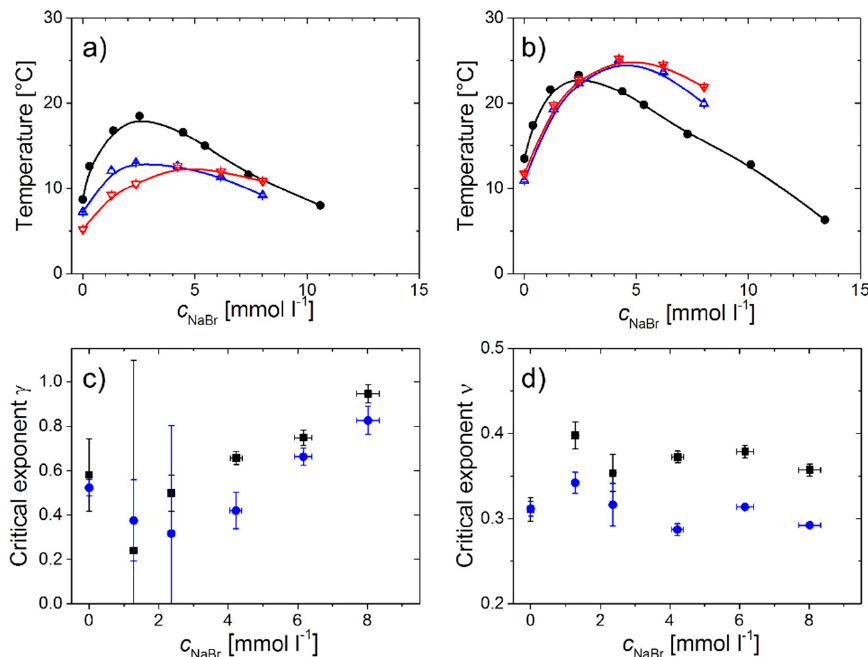
Figure 4. Cloud points measured by turbidimetry (black closed circles, [32]) and spinodal temperatures from fits of Equation (1) to the scattered intensity, T s,I (blue open up triangles), and of Equation (2) to the dynamic correlation lengths, T s, ξ (red open down triangles). ( a ) PSPP 85 and ( b ) PSPP 280 , both at 5 wt.% in H 2 O. The lines guide the eye. ( c , d ) Exponents γ from Equation (1) ( c ) and ν from Equation (2) ( d ). Black squares: PSPP 85 , blue circles: PSPP 280 .